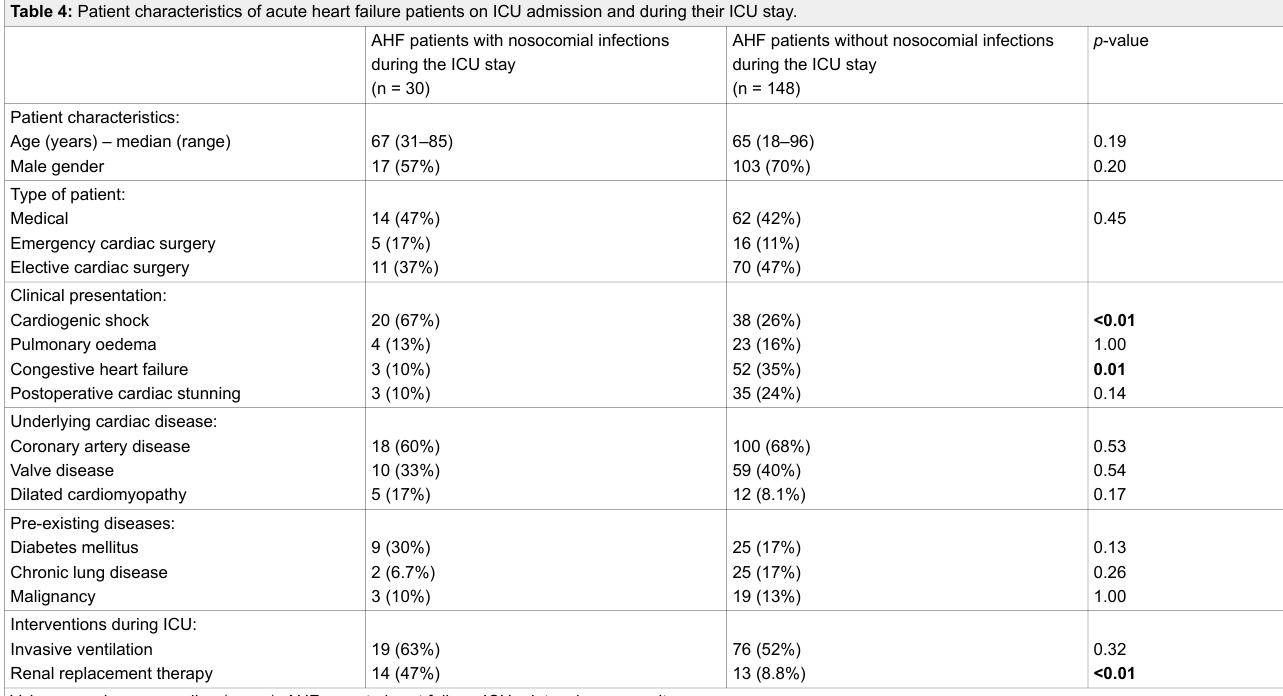
Table 4: Patient characteristics of acute heart failure patients on ICU admission and during their ICU stay.